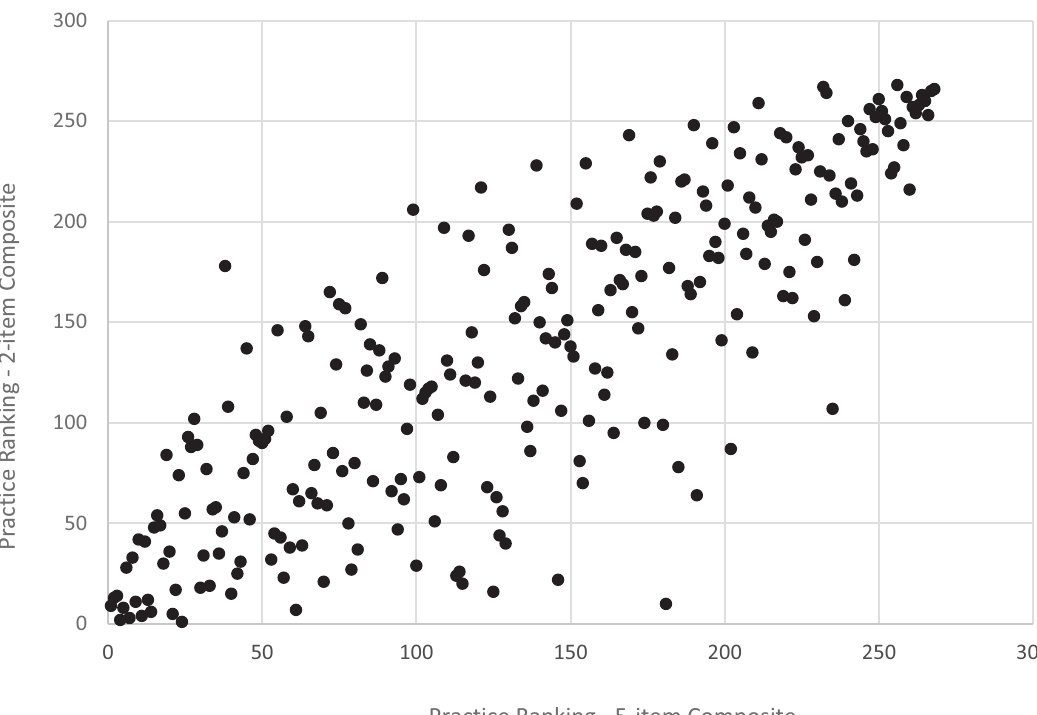
Figure 3. Practice ranking, revised vs . original adult access composite, CAHPS PCMH 2013 ( n = 268 practices).